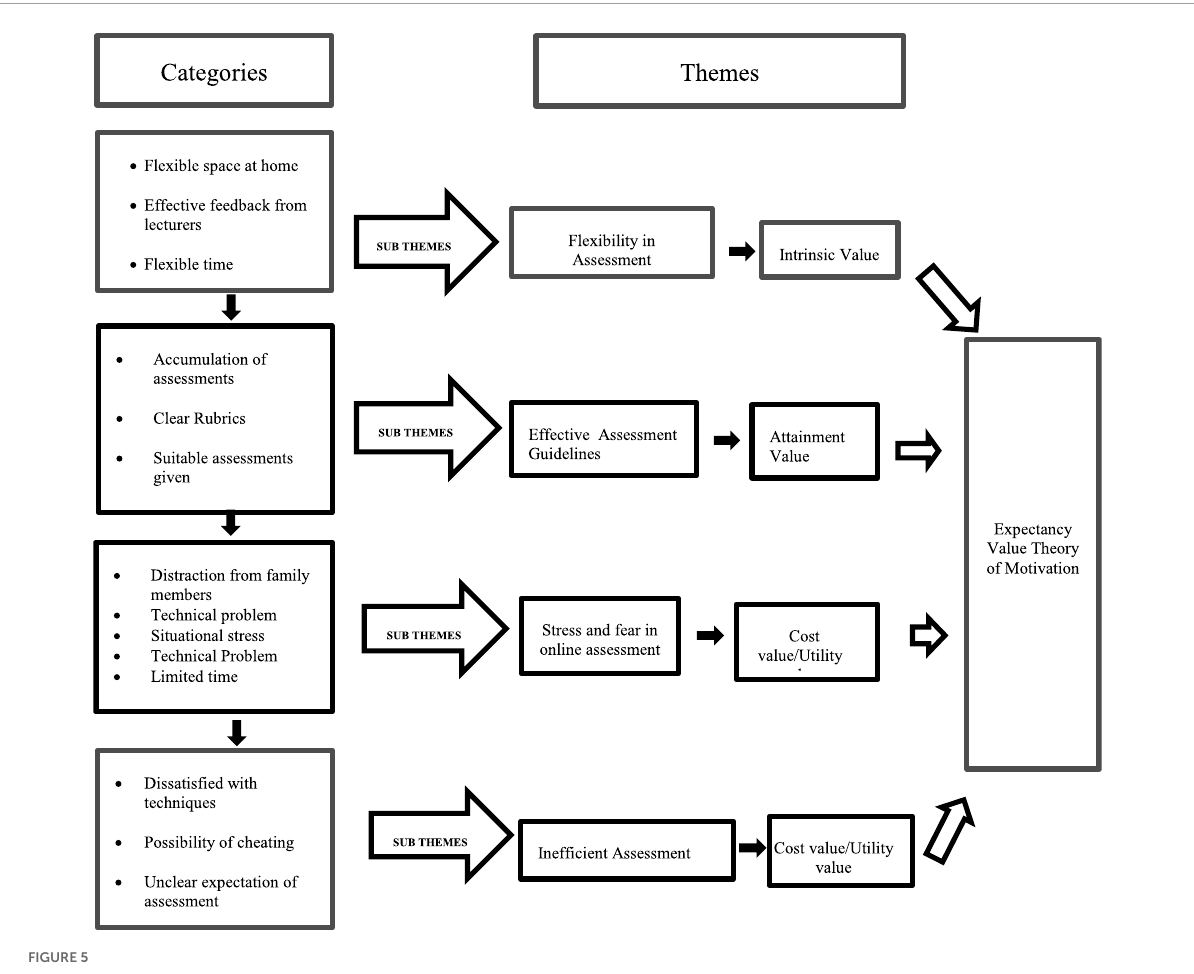
FIGURE5 Categories and themes related to online